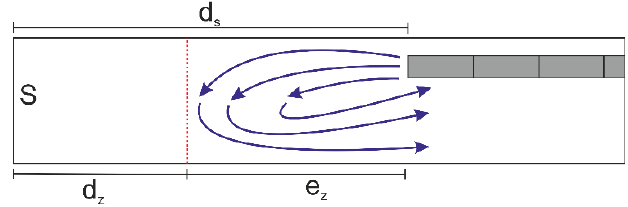
Figure 1. Section (S), dead (d z ) and effective zones (e z ) for a drivage forcing ventilation system.